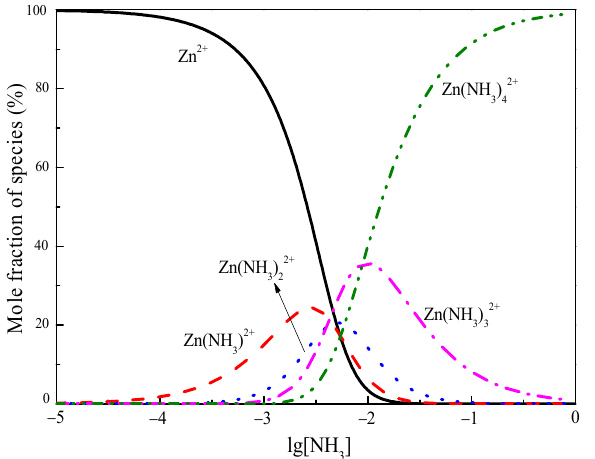
Figure 4. The relationship between the distribution of zinc-ammonia complexes and lg[NH 3 ]. Solid-fluid heterogeneous reactions are common in chemical and hydrometallurgical processes. To determine the kinetic parameters and the rate-controlling step of the zinc leaching process, the popular shrinking core model was utilized. The shrinking core model was proposed by Levenspiel in 1972 when the gasp-solid reaction was studied [22]. It was mainly divided into two categories: the shrinking core model with constant particle size and the shrinking core model with reduced particle size [23]. The schematic diagram of the evolution of the leaching process is shown in Figure 5, and the kinetic equation of